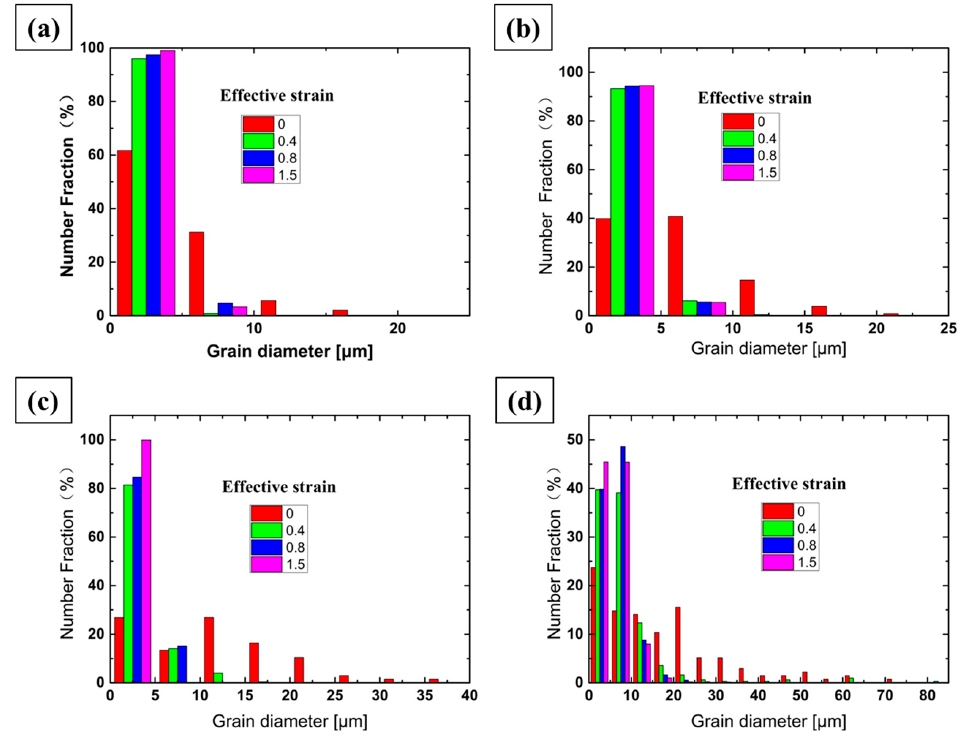
Figure 12. Grain size distribution of the heated and deformed specimens at: ( a ) 960 ° C, ( b ) 990 ° C, ( c ) 1010 ° C, ( d ) 1040 ° C.